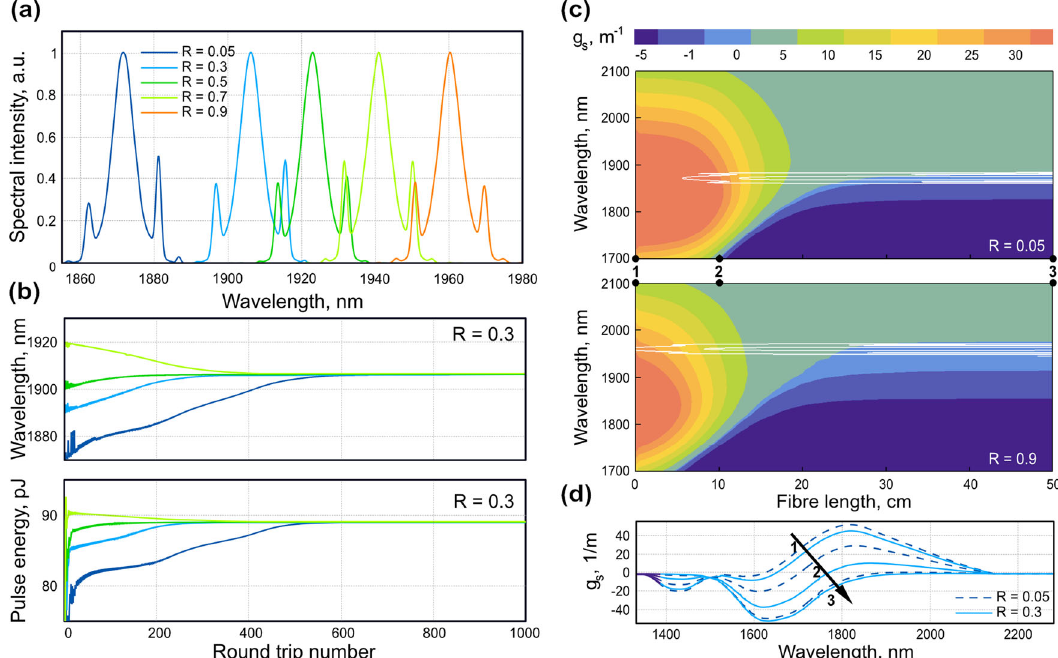
Fig. 4 Numerical simulations results of pulse tuneability. a Calculated output spectra corresponding to varying cavity feedback R = 0.05 – 0.9; b convergence to steady-state regime of pulse generation from different seed parameters in simulations; c evolution of the gain pro fi le along ampli fi er for R = 0.05 (i) and R = 0.9 (ii). Insets: white lines depict the pulse spectrum; d gain spectra at different points ( “ 1 ” , “ 2 ” and “ 3 ” ) along the fi bre at 5 and 90% cavity